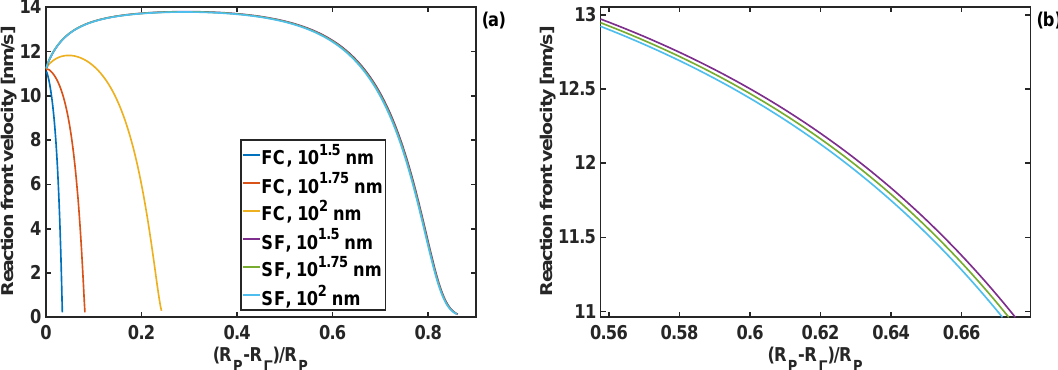
Figure 12: Reaction front velocity profiles of the fully-constrained particle; (a) for different Figure 12. Reaction front velocity profiles of the fully-constrained particle. ( a ) For different coating shear moduli and coating bulk modulus K T = 1 GPa and thickness of h T = 10 2 nm; ( b ) For different coating shear moduli and coating bulk modulus K T =1 GPa and thickness of h T =10 2 nm; (b) coating bulk moduli and coating shear modulus G T = 1 GPa and h T = 10 2 nm. for different coating bulk moduli and coating shear modulus G T =1 GPa and h T =10 2 nm.